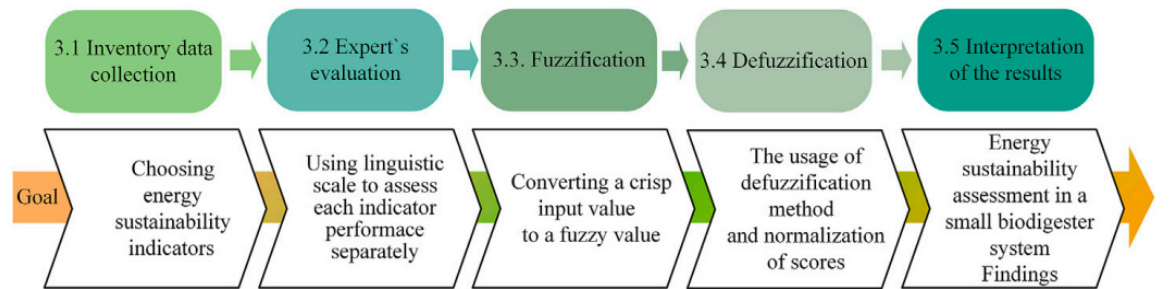
Figure 1. Procedural profile of the P2G process. Source: Liu et al. (2021).